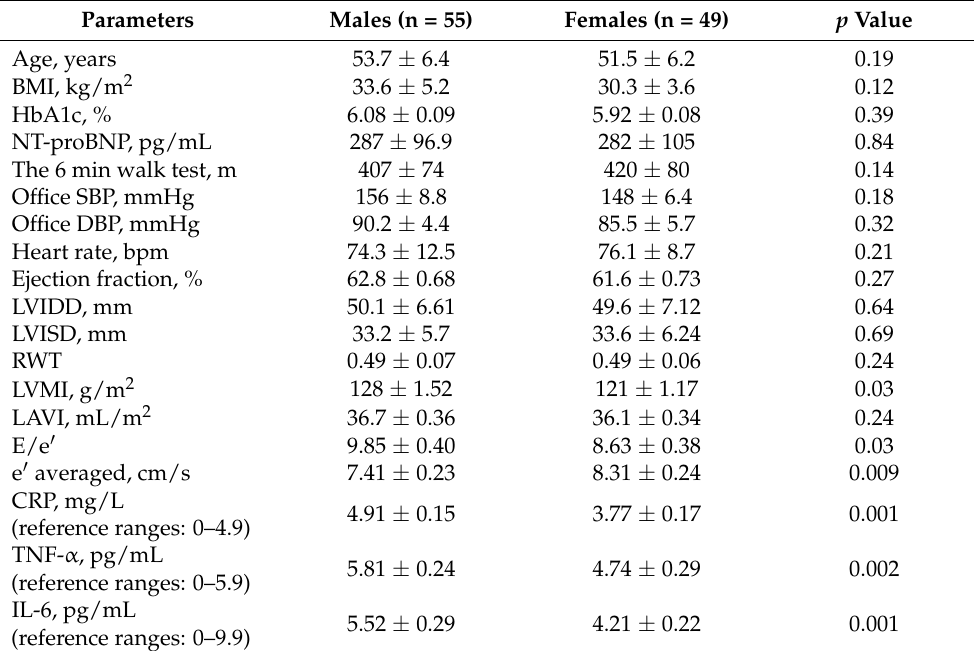
Table 1. The baseline characteristics of the examined patients with essential HTN complicated by HFpEF (M ± std.